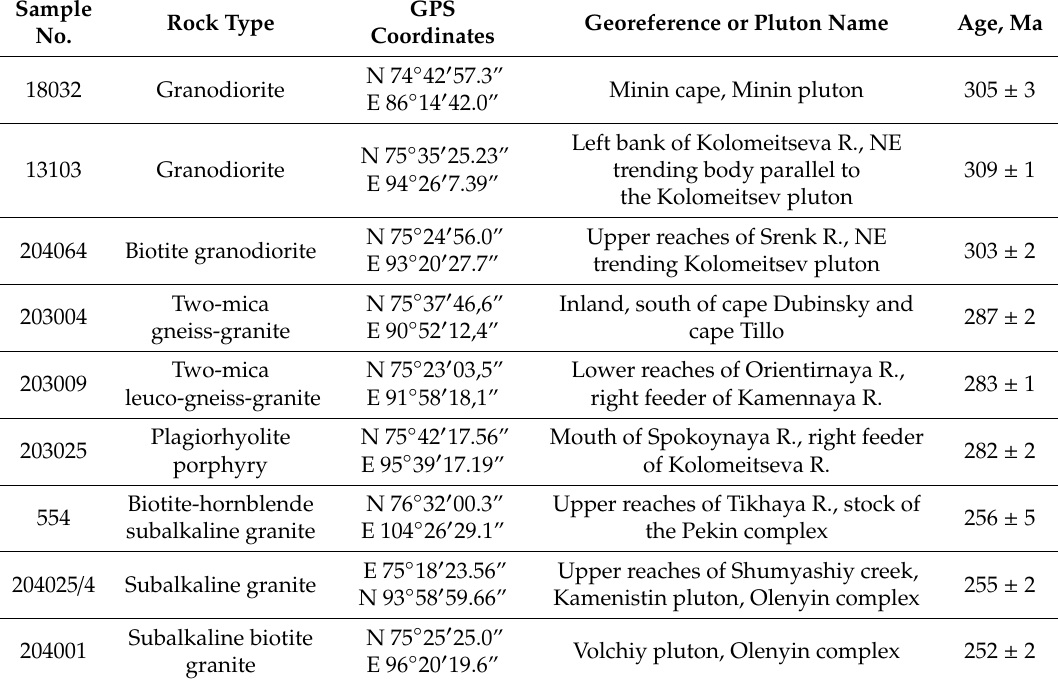
Table A1. Coordinates and georeferences for the studied samples granitoid